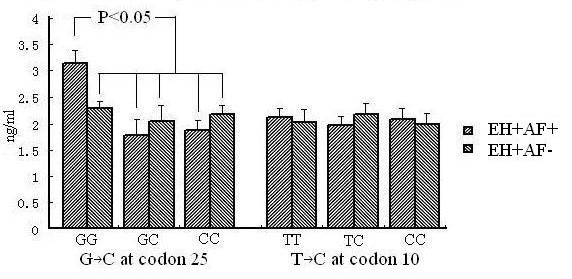
Serum TGFβ1 level according to the genotype profile.